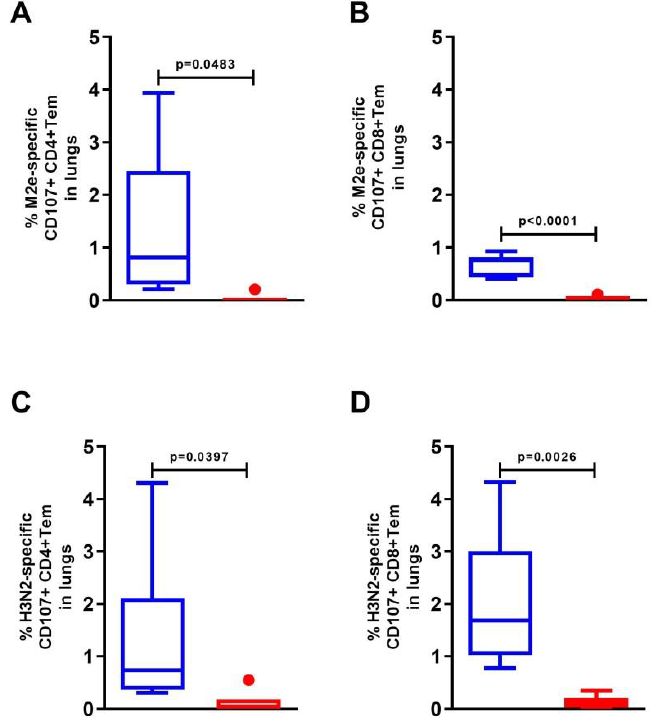
Figure 5. Expression of the degranulation marker CD107a+ on M2e- ( A , B ) and A/H3N2-specific ( C , D ) effector CD4+ and CD8+ memory T cells in the lungs of C57Bl6 mice after intranasal immunization with recombinant protein Flg-HA2-2-4M2ehs. The data are presented as Tukey plots. The data of two experiments ( n = 6) were summarized. Significant differences from the control are shown. Table 1. Functional characteristic of antigen-specific CD8+Tem lungs cells in C57Bl/6